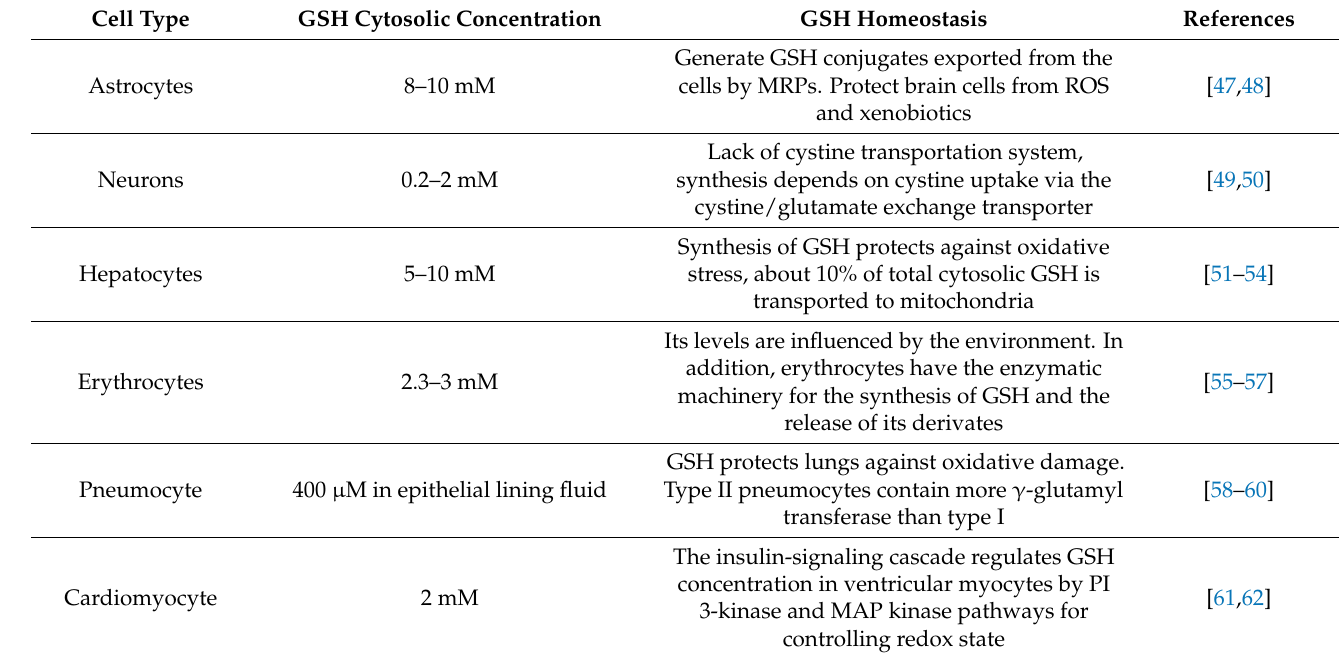
Table 1. Glutathione distribution and homeostasis in different cell